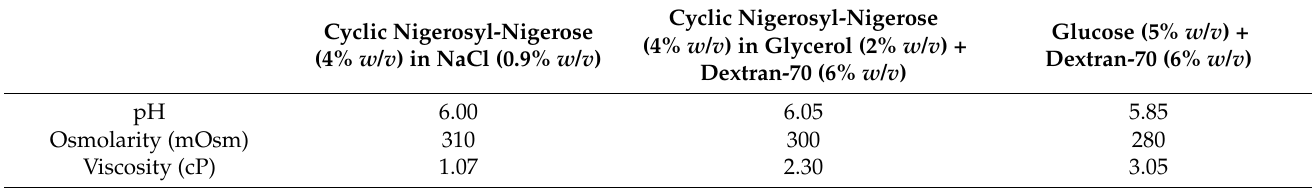
Table 1. Characteristics of oxygen-loaded cyclic nigerosyl-nigerose samples.